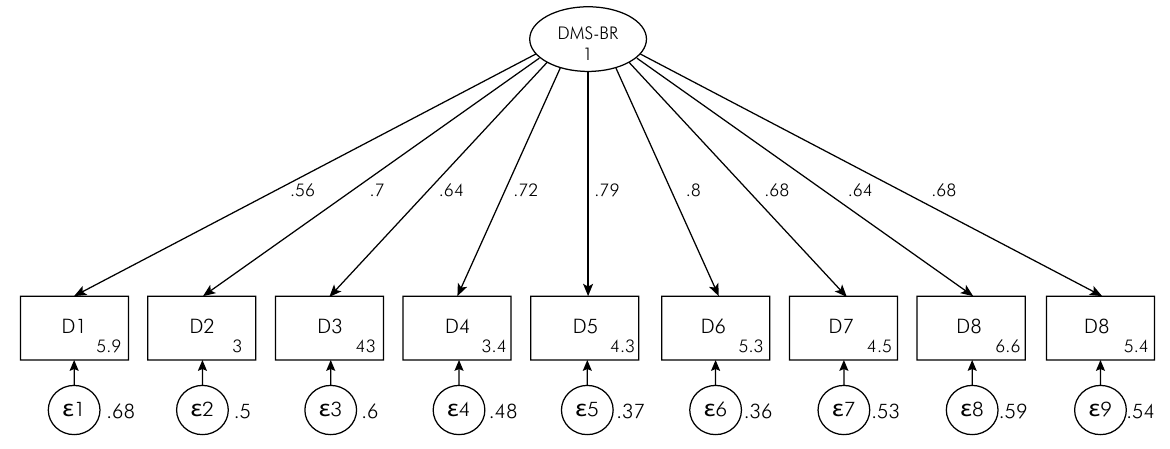
Figure. Structural equation modeling for